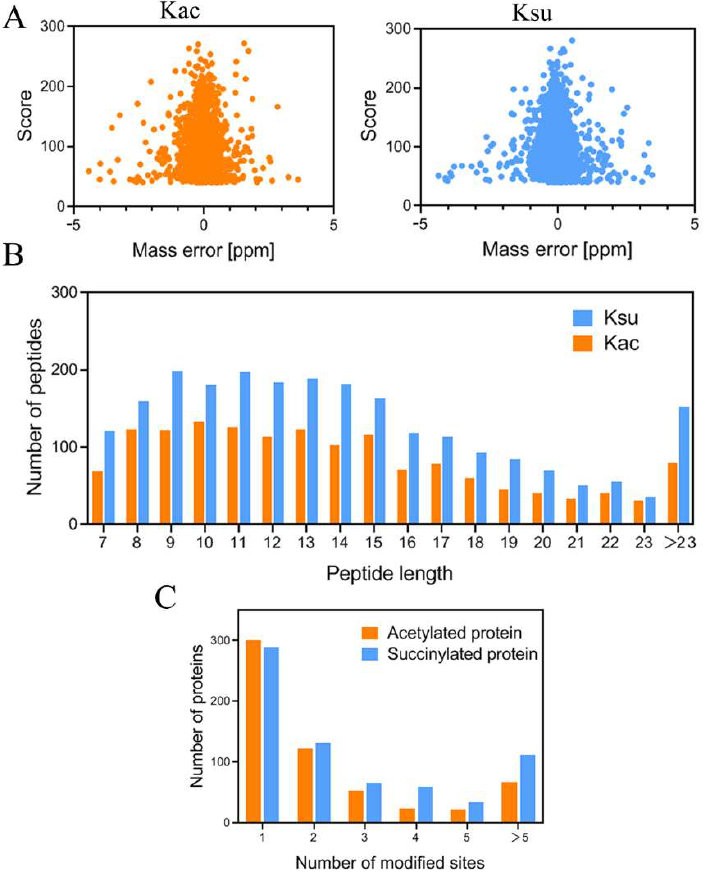
Figure 1. Profile of E. tarda lysine acetylation and succinylation proteome. ( A ) Distributions of mass errors for Kac and Ksu peptides. ( B ) Distributions of Kac and Ksu peptides based on their lengths. ( C ) Distributions of modified sites in Kac and Ksu proteins. Table 1. The PTMs of AMR proteins in previous reports and in this study.